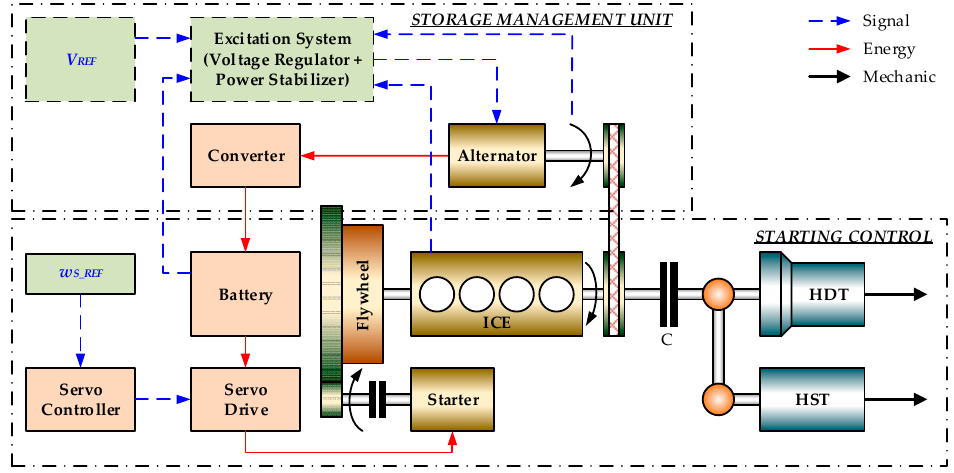
Figure 1. Powertrain configuration of the targeted excavator [12]. Table 1. Specifications of the main powertrain components.